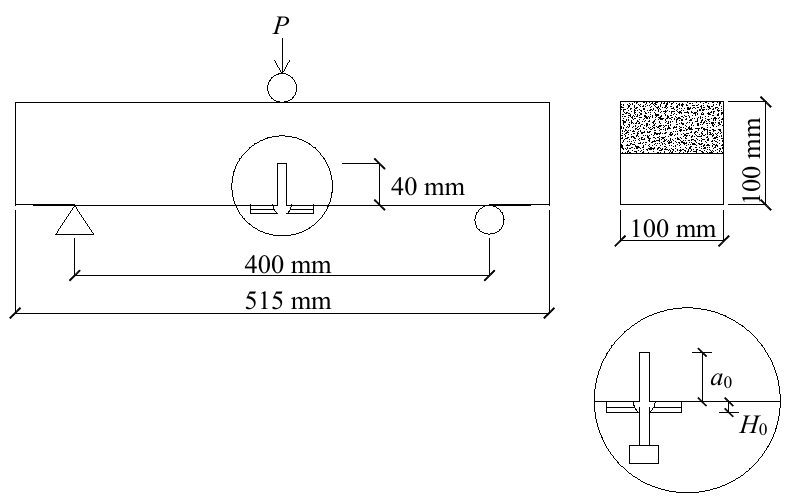
Figure 2. Configuration of TPB test beams.